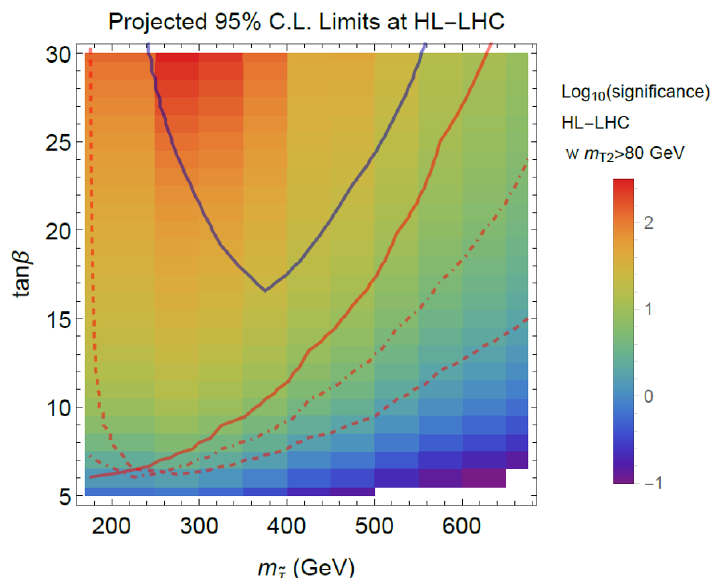
Figure 11 . Projected 95% C.L. exclusion sensitivity at the HL-LHC, for m A = 2 m ~ (cid:28) and m LSP = 100 GeV, using the cuts outlined in table 1. The solid, dot-dashed, and dotted red curves correspond to the proposed search with m T 2 > 40 ; 80 ; 120 GeV, respectively. The blue curve corresponds to the sensitivity derived from applying the heavy Higgs to (cid:28)(cid:28) search strategy [1] to our Higgs decay to stau signal sample, projected to HL-LHC with 3 ab (cid:0) 1 of integrated luminosity. The colors show the signi(cid:12)cance using the m T 2 > 80 GeV signal region.